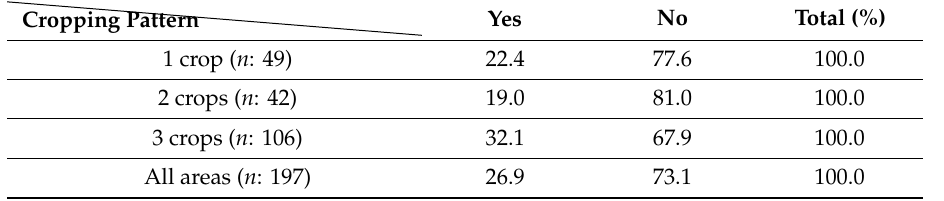
Table 8. Respondents who wanted to shift from row sowing to transplanting machine (%). Cropping Pattern